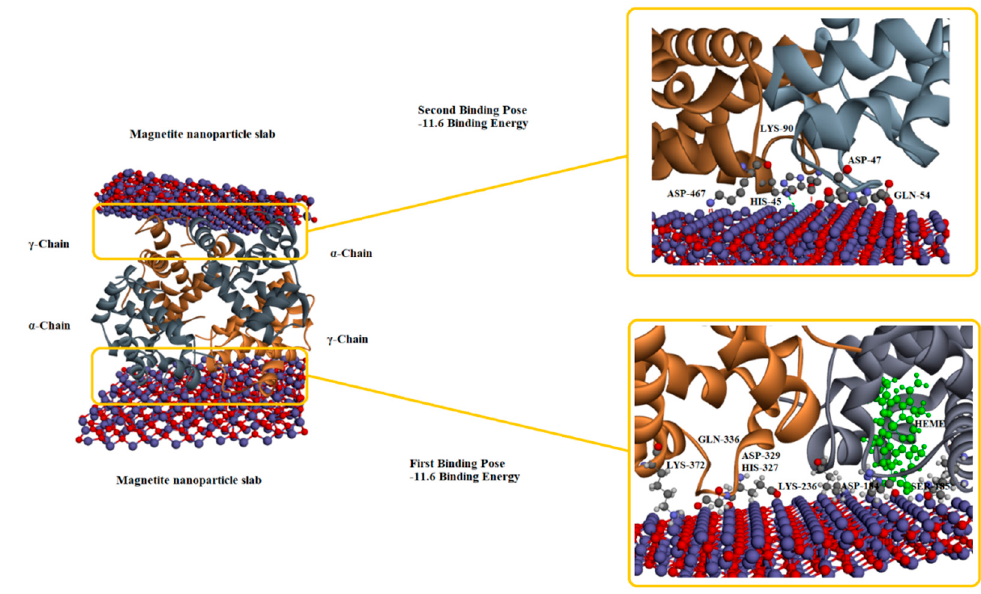
Figure A2. Interaction of hemoglobin HbF with bare magnetite nanoparticle slab.